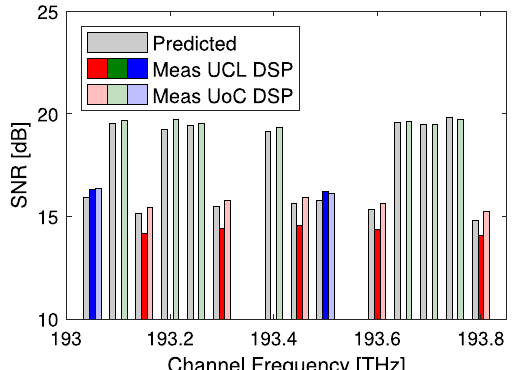
Figure 3. Received performance. Measured performance and predicted performance of signals received at UCL. The performance histograms are grouped around the channel frequency. The bold colours correspond to signals analysed with UCL DSP while the pale colours are the same data captures processed with UoC DSP. Signals transmitted from UoC, UoB and UCL are coloured red, green and blue respectively 21 .